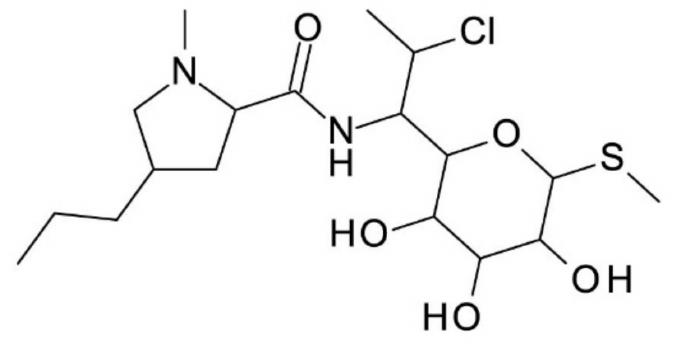
Figure 9. Chemical structure of